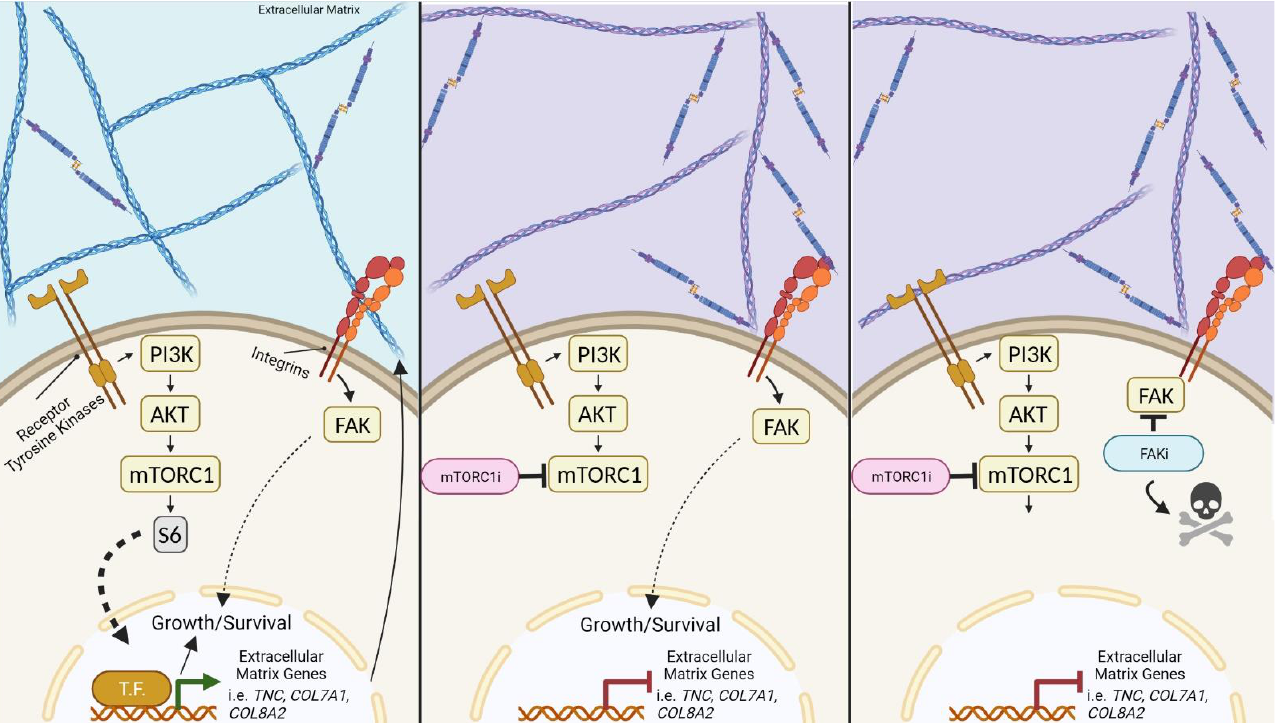
Figure 6. Targeting FAK blocks growth dependence on extracellular matrix following mTORC1 inhibition. mTORC1 inhibition initiates a transcriptional reprogramming of extracellular matrix genes that drives ECM remodeling to maintain growth. The inhibition of FAK abolishes the ability of cells to utilize the ECM as a collateral growth-stimulating pathway. Abbreviations: mTORC1i, mTORC1 inhibition; FAKi, focal adhesion kinase inhibition; T.F., transcription factor.